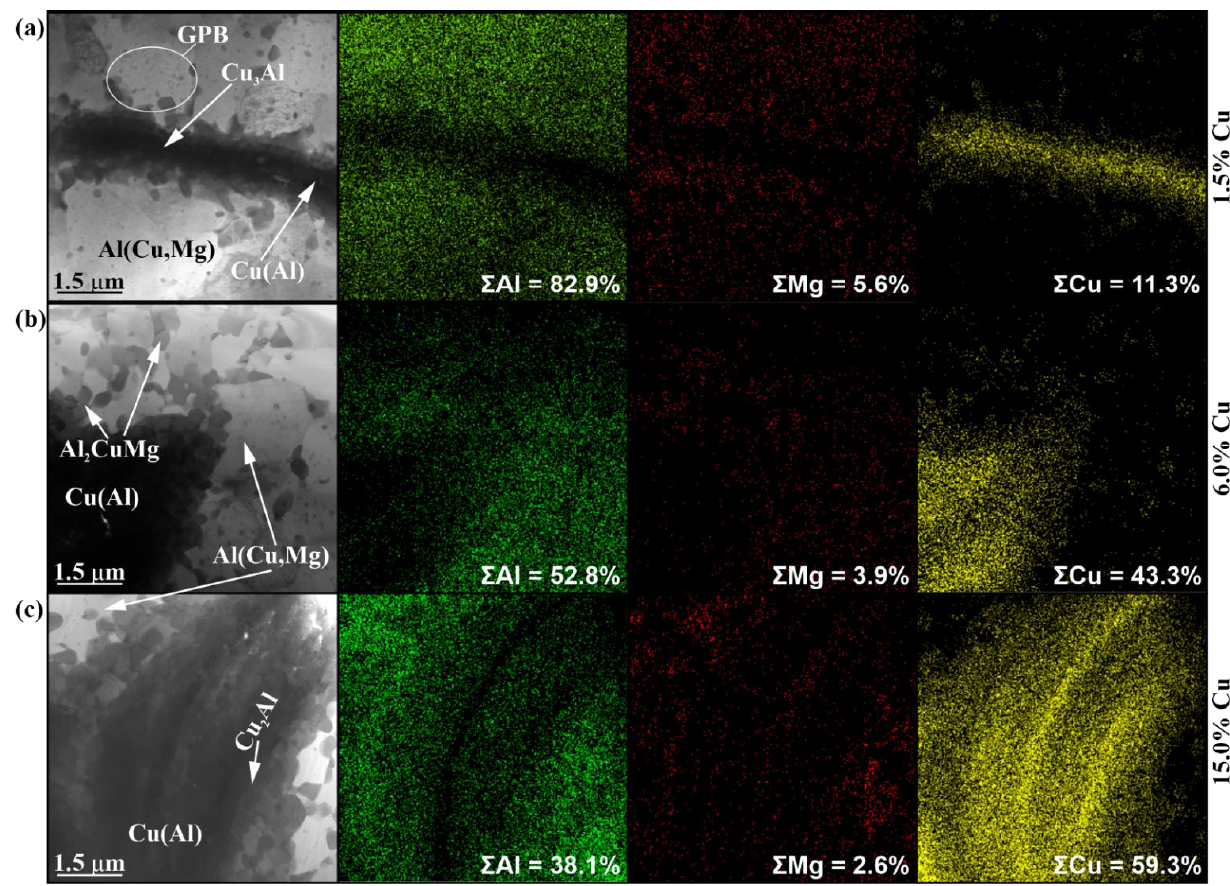
Figure 13. The bright-field TEM images of IMC agglomerate particles in the 4-pass samples after FSP with 1.5 vol.% ( a ), 6.0 vol.% ( b ) and 15 vol.% Cu ( c ) with corresponding EDS maps.